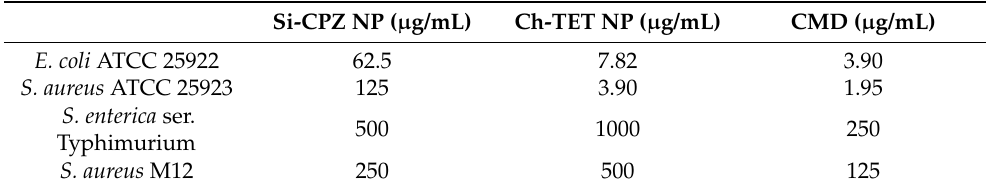
Table 2. Minimum inhibitory concentration ( µ g/mL) of Ch-TET NP, Si-CPZ NP and